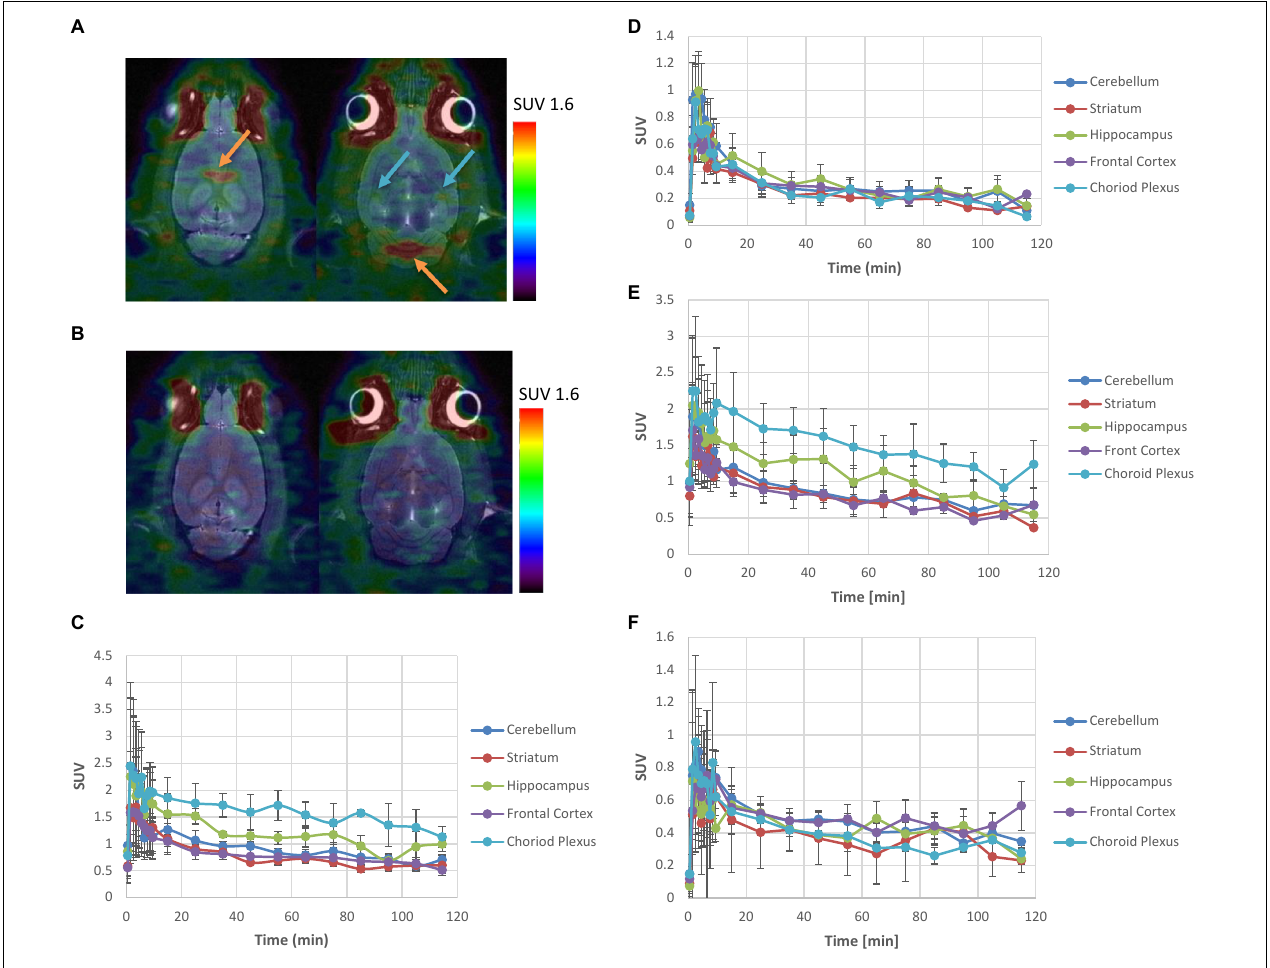
FIGURE 2 | PET analysis of [ 11 C] 6 and [ 11 C] 9 in Sprague–Dawley rats. (A) Summed images of [ 11 C] 6 PET/CT data from 10 to 120 min p.i. at baseline. Orange arrows depict choroid plexus; Blue arrows depict hippocampus. (B) Summed images of [ 11 C] 6 PET/CT data from 10 to 120 min p.i. after pretreatment with 0.1 mg/kg of SB-242084. (C) Mean ( n = 3) time-activity curves for brain regions of interest of [ 11 C] 6 at baseline with standard error. (D) Mean ( n = 3) time-activity curves for brain regions of interest of [ 11 C] 6 after pretreatment with 0.1 mg/kg of SB-242084 with standard error. (E) Mean ( n = 3) time-activity curves for brain regions of interest of [ 11 C] 9 at baseline with standard error. (F) Mean ( n = 3) time-activity curves for brain regions of interest of [ 11 C] 9 after pretreatment with 0.1 mg/kg of SB-242084 with standard